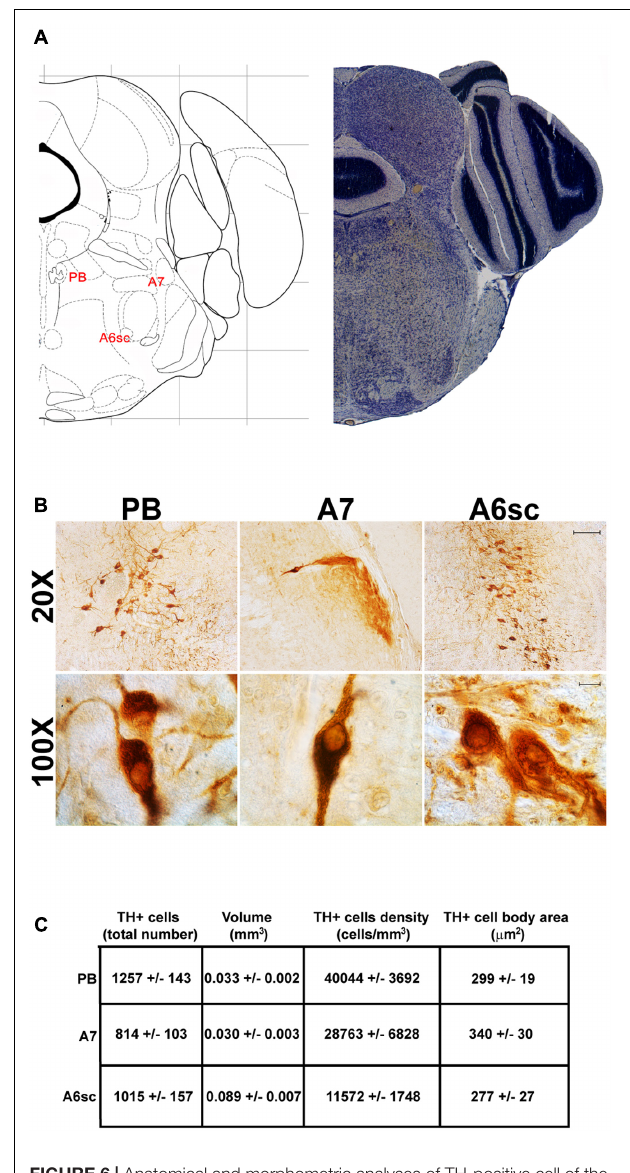
FIGURE 6 | Anatomical and morphometric analyses of TH-positive cell of the PB, A7, and A6sc catecholaminergic nuclei. (A) Nissl staining of the mouse brain at the Bregma level –5 (Paxinos and Franklin, 2001) showing the anathomical localization of the PB, A7 noradrenergic group and the A6sc. (B) Representative images of TH immunoreactive cells of the PB, A7, and A6sc. Images at higher magnification (100X) show the morphological features of these TH positive cells. Scale bar: 100 µ m for 20X and 10 µ m for 100X. The corresponding morphometric analyses are shown in (C) . Values are means ±